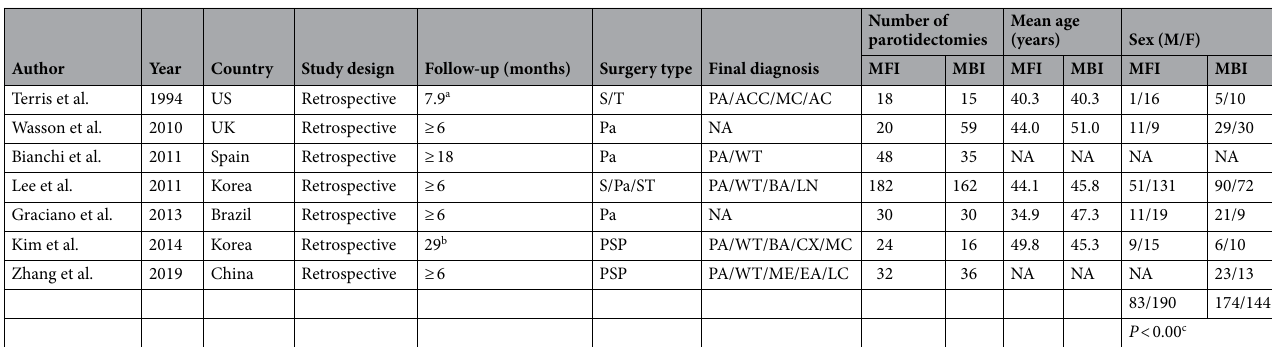
Table 1. Characteristics of the included studies. M male, F female, MFI modified facelift incision, MBI modified Blair incision, US United States, HK Hong Kong, UK United Kingdom, S superficial parotidectomy, T total parotidectomy, Pa partial parotidectomy, ST subtotal parotidectomy, PSP partial superficial parotidectomy, NA not available, PA pleomorphic adenoma, ACC adenoid cystic carcinoma, MC LC lymphoepithelial cyst. a Follow-up period is presented as the mean. b Follow-up period is presented as the median. c P -value from the chi-square test comparing the distribution of males and females in the MFI and MBI